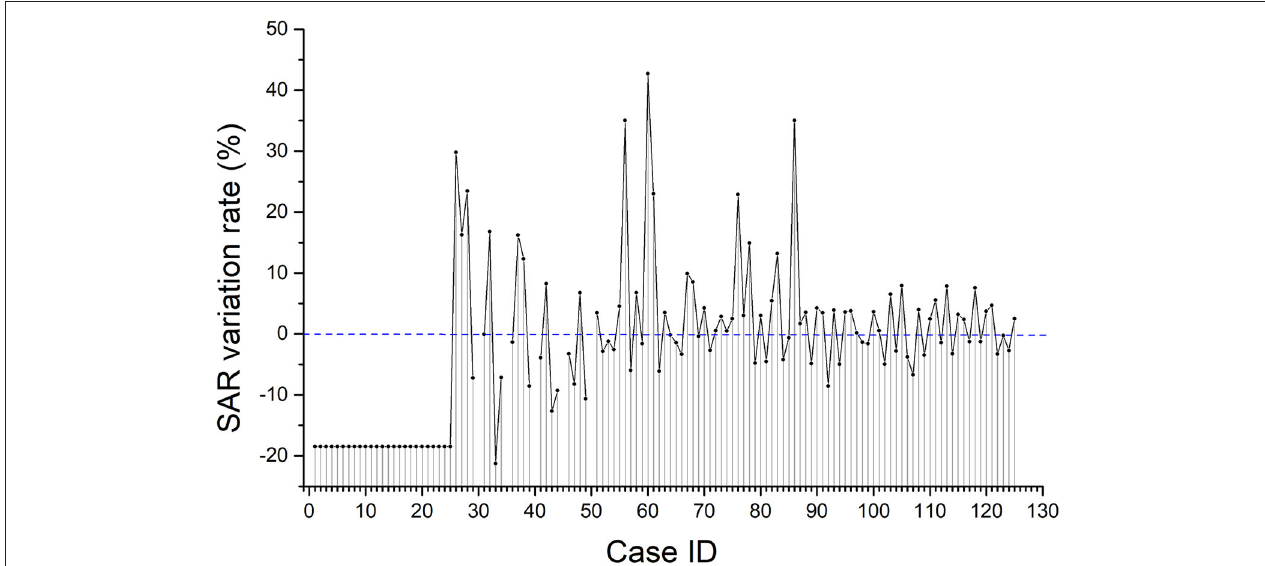
FIGURE 7 | The variation rate of the WB-avgSAR of rat 1 under each relative gesture